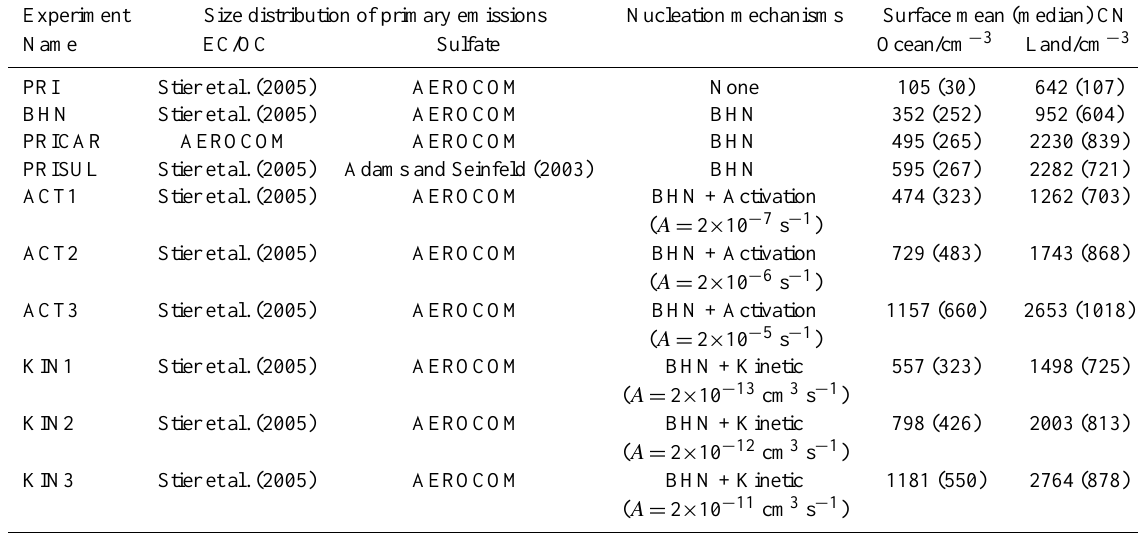
Table 1. Simulated annual mean (median) surface CN ( Dp> 3nm) concentrations (at ambient temperature and pressure) for the year 2000 for model experiments with different primary emissions and particle formation (see Sect. 2.2 for